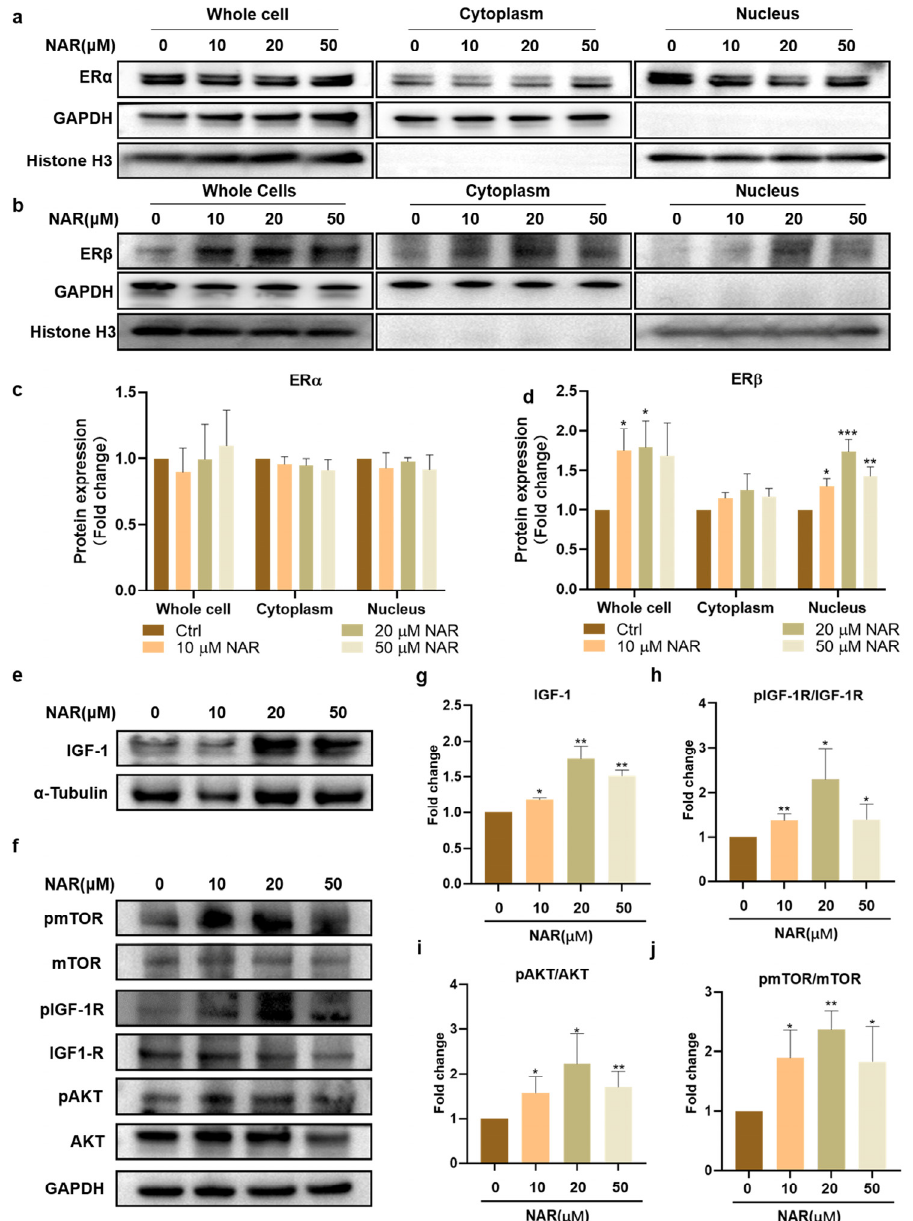
Figure 4. NAR upregulated ER β and IGF-1 signaling during myogenesis. ( a , b ) Representative blots of ER α , ER β , GAPDH, and Histone H3 in whole cells, cytoplasm, and nucleus. Protein was extracted from P6 PSCs after three days of differentiation in the absence or presence of NAR (10, 20, 50 µM). ( c , d ) Quantification of Er α and ER β ratios according to ( a , b ). The bar chart presents the quantification of blot band intensity, normalized to GAPDH or histone H3 levels, and presented as fold change relative to the sample without treatment of NAR ( n = 3 biological replicates). ( e , f ) Representative blots of IGF-1, IGF-1R, pIGF-1R, mTOR, pmTOR, AKT, pAKT, GAPDH, and α -tubulin in differentiating P6 PSCs after three days of induction in the absence or presence of NAR (10, 20, 50 µM). ( g ) Quantification of IGF-1 expression according to ( e ). The bar chart presents the quantification of blot band intensity, normalized to α -tubulin levels, and presented as fold change relative to the sample without treatment of NAR ( n = 3 biological replicates). ( h – j ) Quantification of pmTOR/mTOR, pIGF1-R/IGF-1R, and pAKT/AKT ratios according to ( f ). The bar chart presents the quantification of blot band intensity, normalized to GAPDH levels, and presented as fold change relative to the ctrl sample ( n = 3 biological replicates). Error bars represent mean ± SD. The asterisk indicates a significant difference from the ctrl (0 µM NAR) group. * p < 0.05, ** p < 0.01, *** p < 0.001.